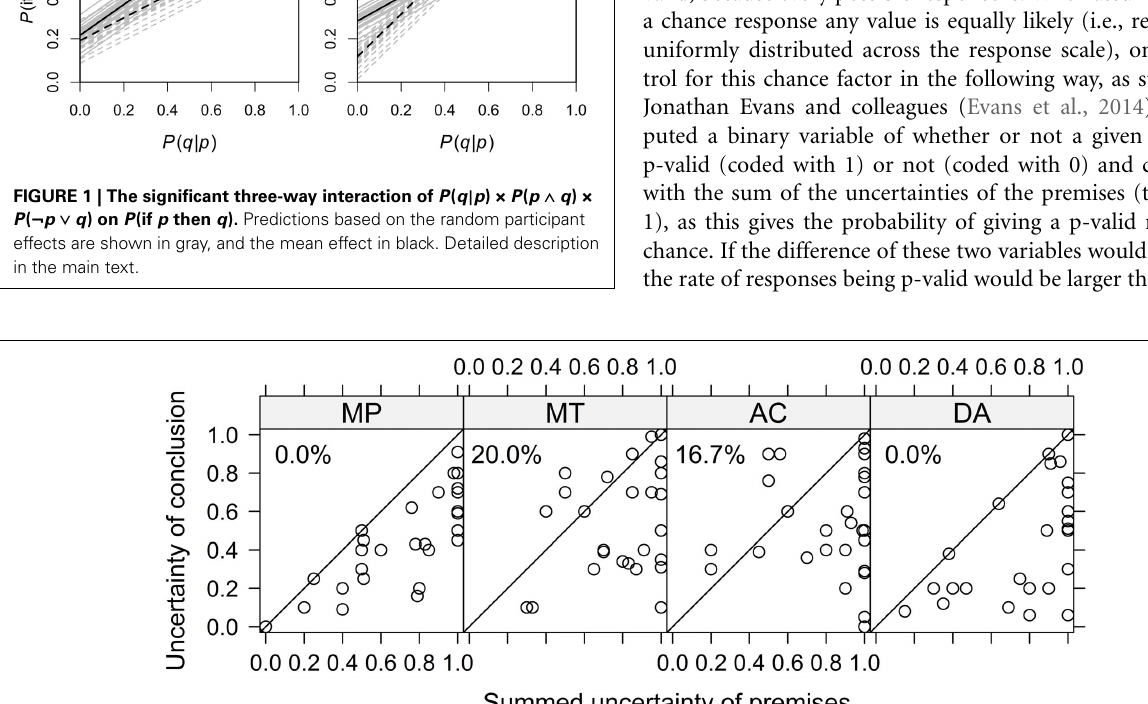
uncertainty of the conclusion is larger than the uncertainty of the premises). For AC and DA no such restriction exists. The numbers in the upper left corner show the percentages of data points in the upper